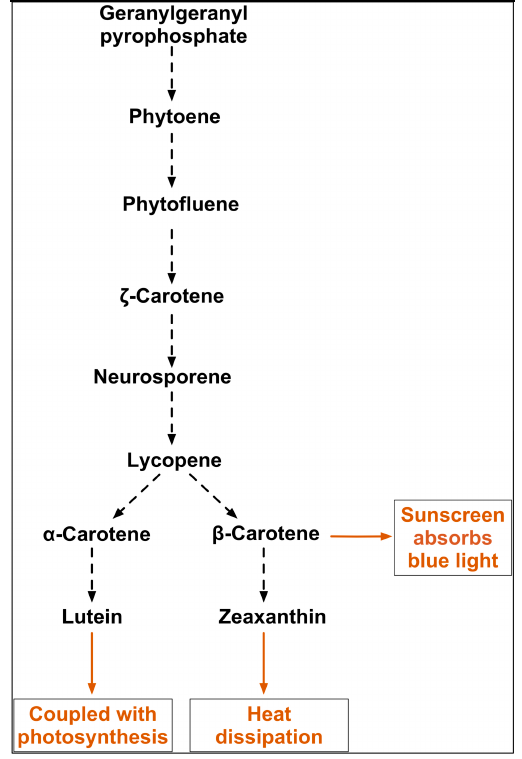
Figure 9. Carotenoids pathway showing synthesis of lutein, β -carotene, α -carotene, and zeaxanthin